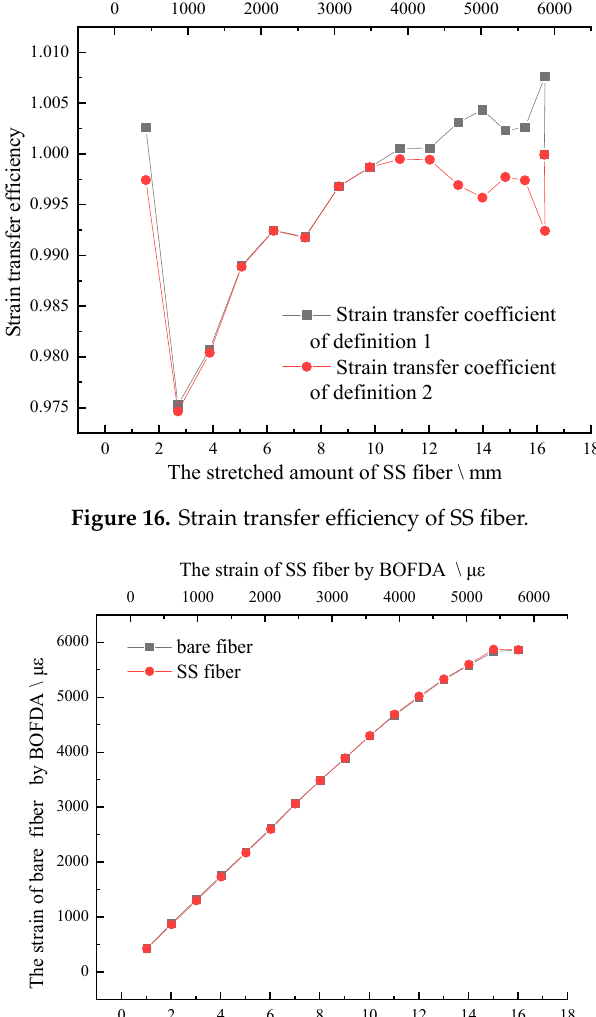
Figure 16. Strain transfer efficiency of SS fiber.